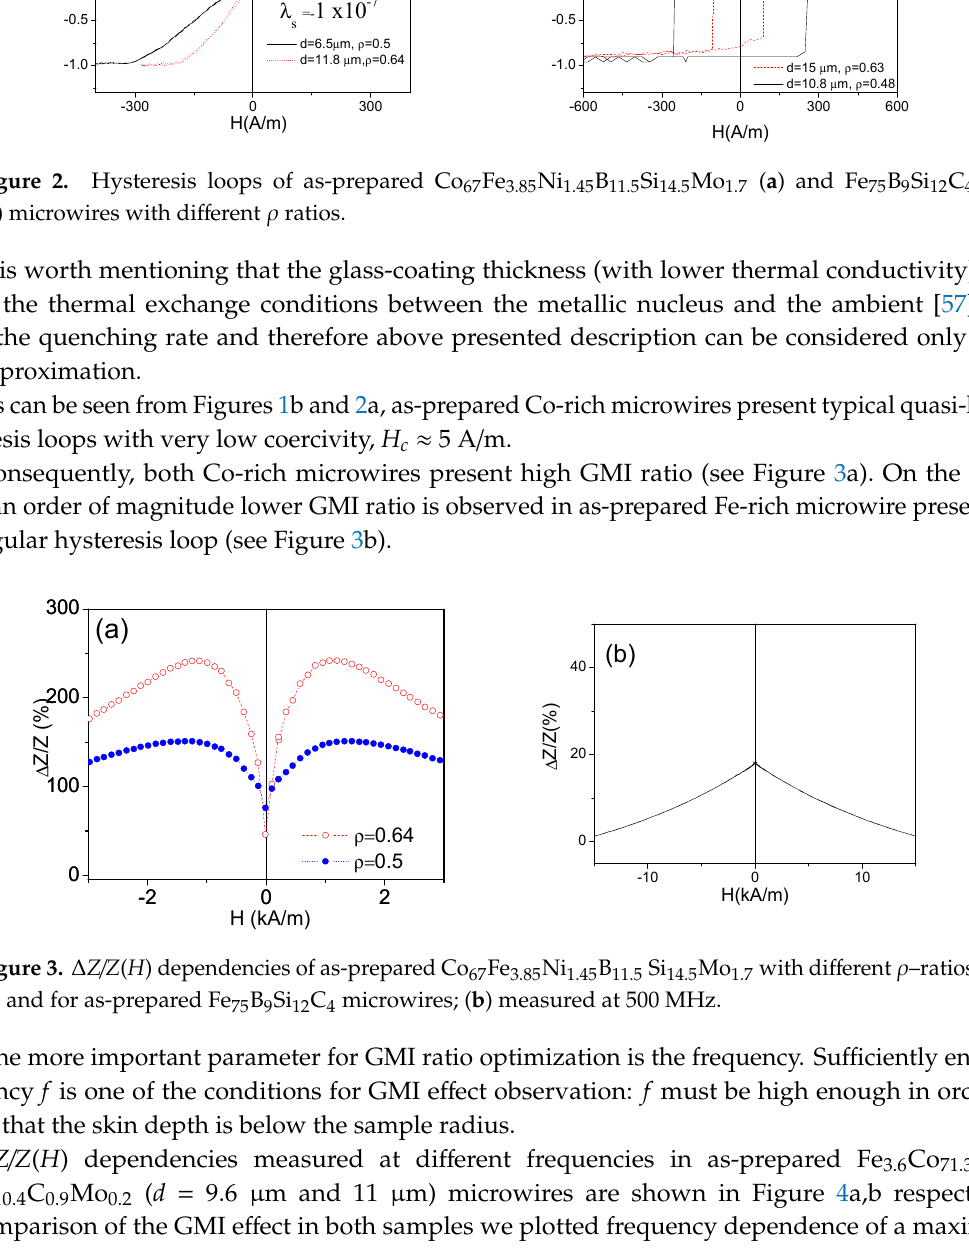
Figure 3. Δ Z/Z ( H ) dependencies of as-prepared Co 67 Fe 3.85 Ni 1.45 B 11.5 Si 14.5 Mo 1.7 with different ρ –ratios ( a ) and for as-prepared Fe 75 B 9 Si 12 C 4 microwires; ( b ) measured at 500 MHz.